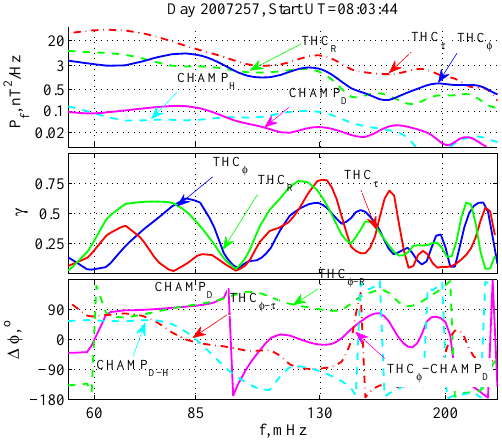
Figure 5. PSD spectra, spectral coherence, γ , and phase difference, (cid:49)ϕ , for the three THEMIS-C and the two horizontal CHAMP com- ponents for the interval shown in Fig.